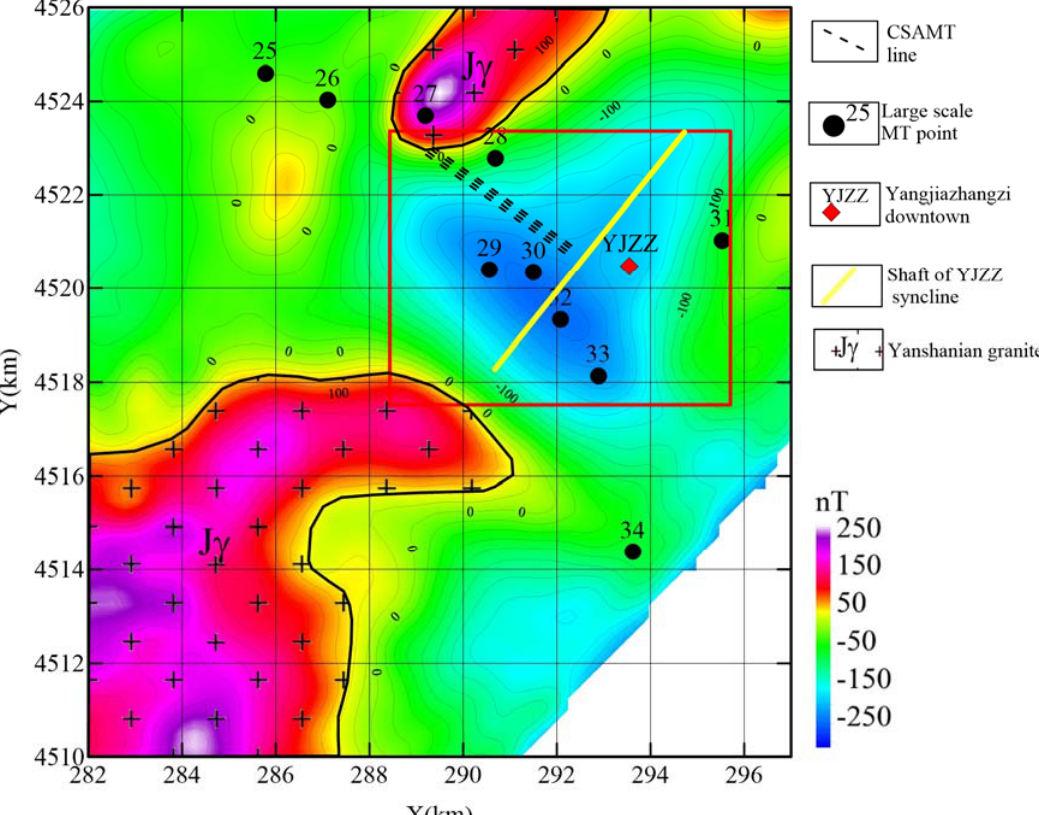
Figure 4. The airborne magnetic anomaly after downward continuation of 200 m. The black points are the large ‐ scale MT stations. There is a low anomalous area symmetrical along the NE direction axis (yellow line), which is inferred to be the YJZZ syncline.